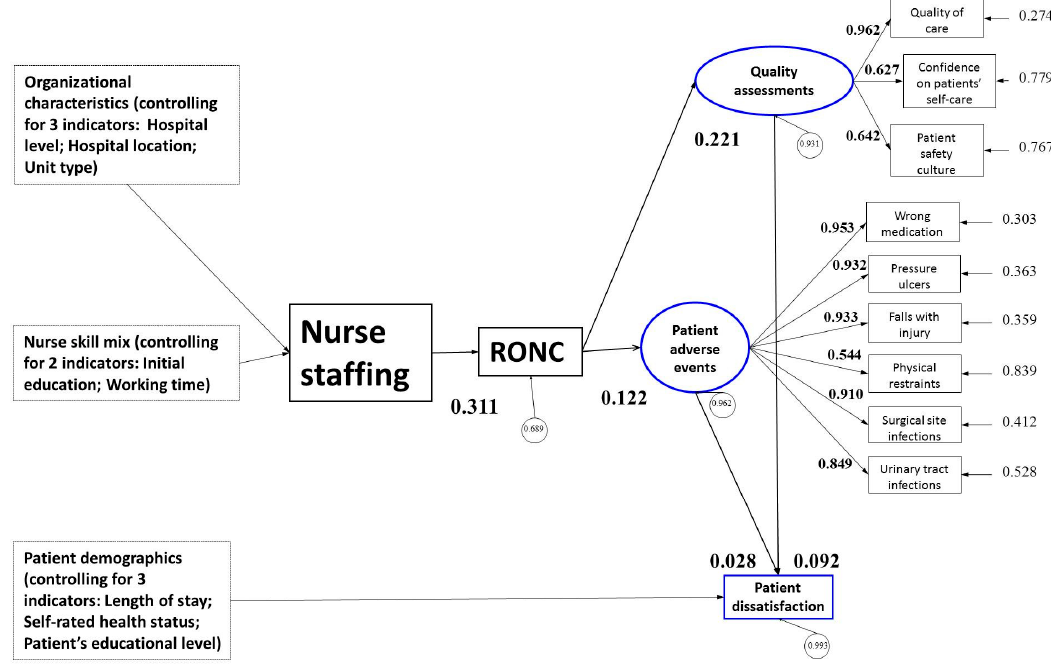
Figure 2. Final structural equation model of nurse staffing and patient outcomes among Chinese hospitals with estimated standardized path coefficients and correlations. Path coefficients were significant ( p < 0.01). Otherwise coefficients are not shown for clarity.